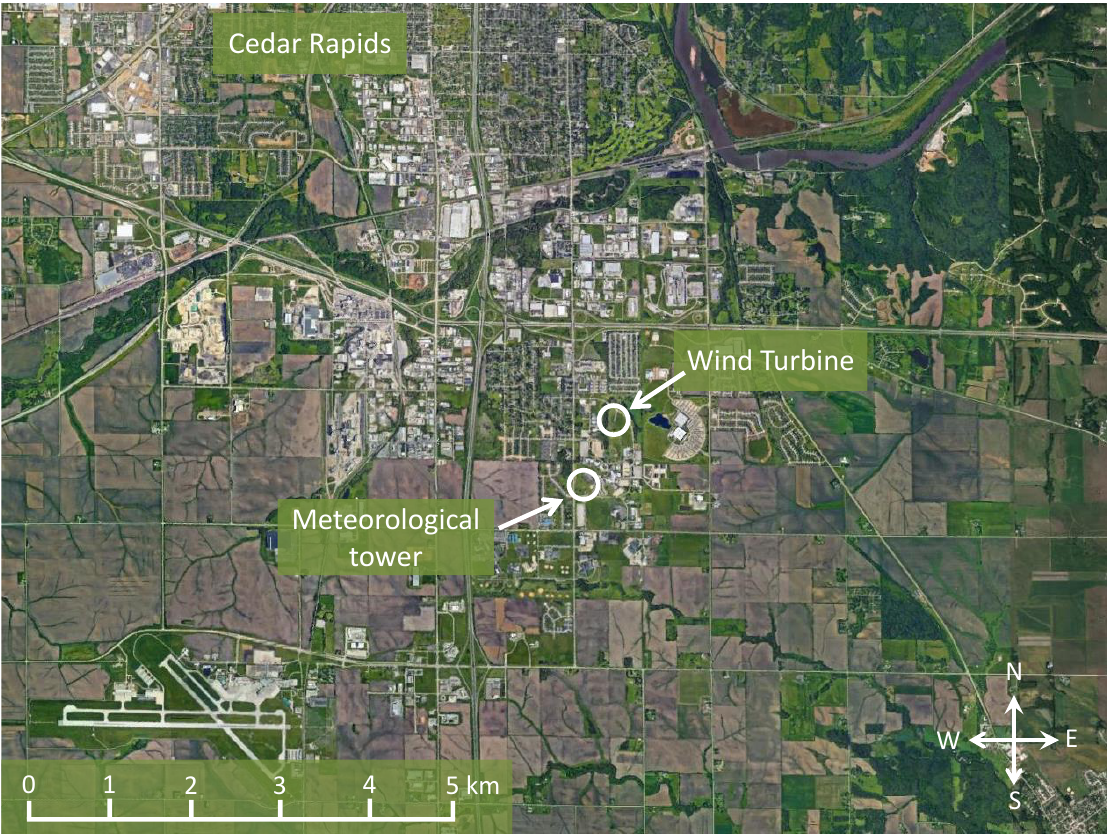
Figure 2. Location of the wind turbine and the meteorological tower inside Kirkwood’s campus as well as the outskirts of Cedar Rapids. Map data: Google, Image